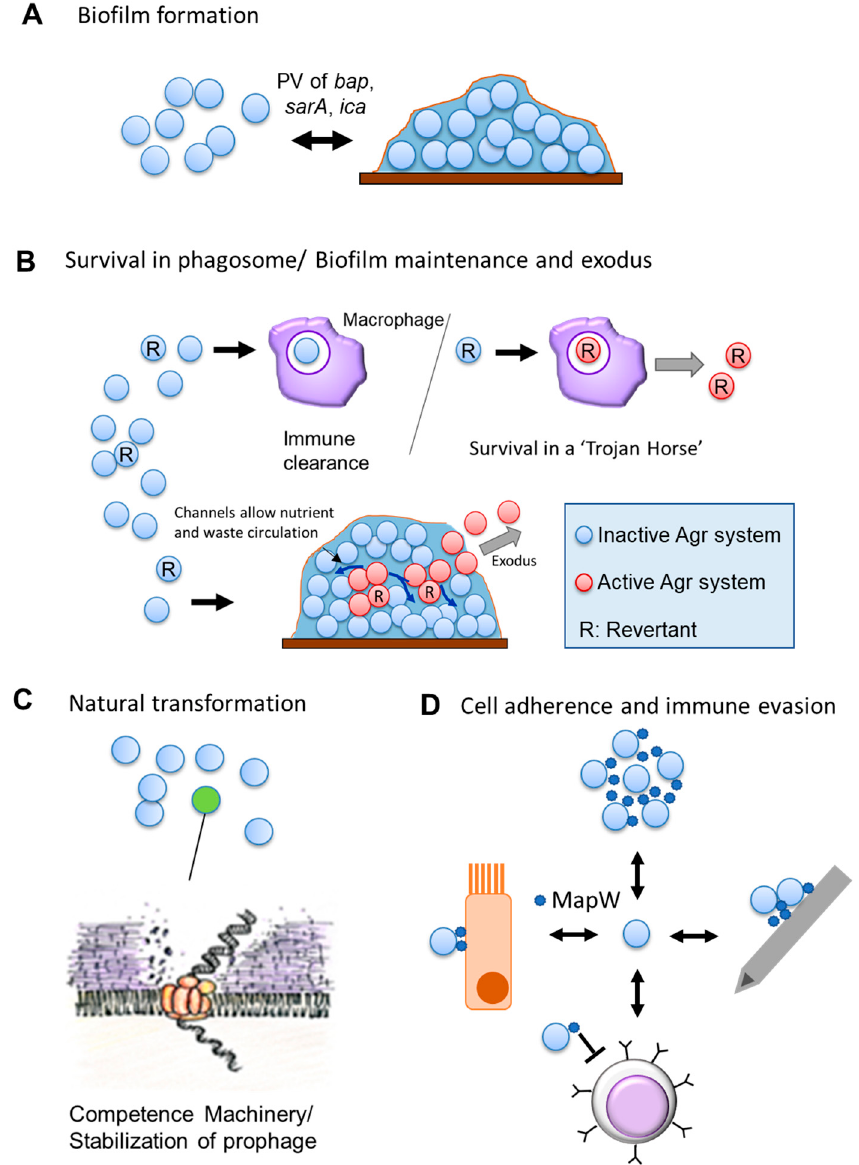
Figure 2. Phase Variation in Staphylococcus aureus . A cartoon depicting known PV in S. aureus and its roles. Double headed arrows indicate reversible PV events. ( A ) PV of Bap (Biofilm Associated Protein) (unclear mechanism) and of the ica (Intracellular Adhesion) operon (transposon insertion and SSR alteration) reversibly affects the biofilm-forming capability. ( B ) Phase variation of the Agr (Accessory Gene Regulator) system may have multiple possible roles [90]. It could serve as a cryp- tic insurance strategy against host immune attack, allowing phagocytosed revertant cells to acti- vate their reverted Agr system to survive within a “Trojan Horse” (Top). It may also aid in the proper structuring of biofilms, as revertant cells and their progeny can activate their Agr system in structured non-planktonic architecture and the resultant exoproteins form channels in the biofilm for circulation of waste and nutrients as well as facilitating the exodus of cells from the biofilm [93] (Bottom). ( C ) PV-like expression is one of two independent expression mechanisms known for the alternative sigma factor σ H . Either mechanism allows for a subpopulation of cells to express the competence machinery and undergo natural transformation. ( D ) PV of the cell-wall associated MapW (MHC class II Analog Protein) may have multiple impacts [94]. MapW is involved in bacte- rial aggregation and may lead to biofilm formation; It is also implicated in the adherence to the host matrix and in-dwelling medical devices (e.g., cannulas); MapW has immunomodulatory ef- fects and seems to suppress T-cells and their recruitment, though the exact mechanism remains